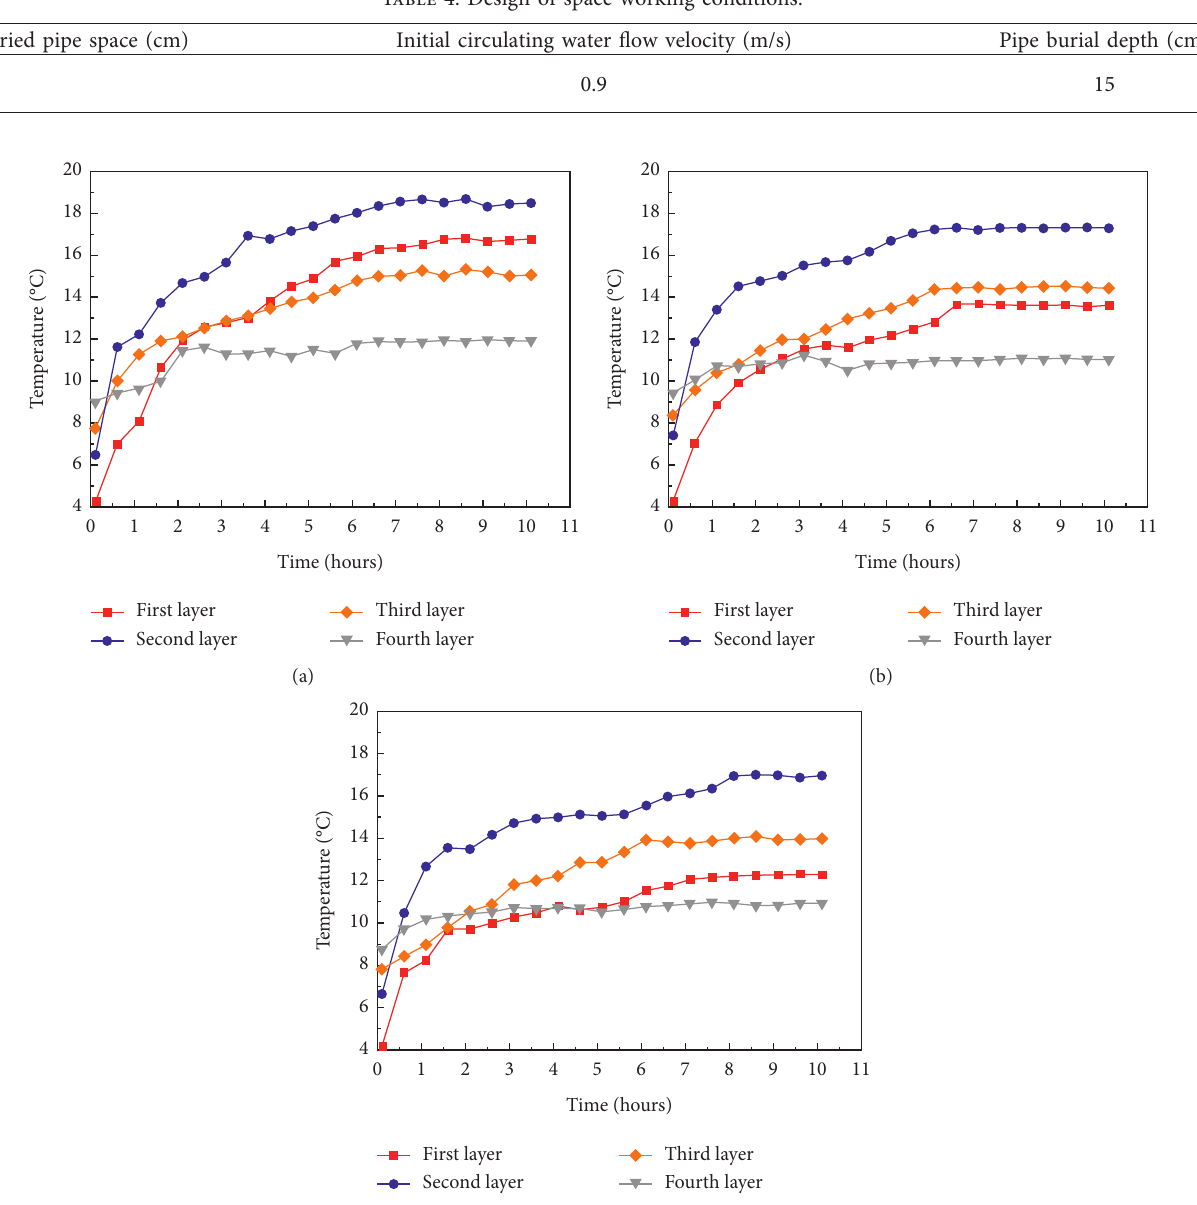
Table 4: Design of space working conditions.